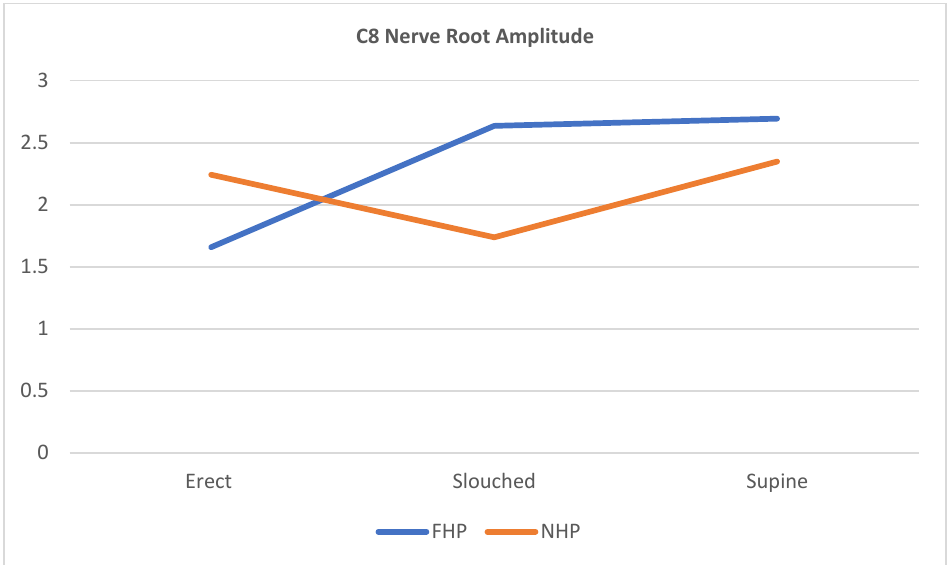
Figure 9. Scatterplot line of cervical nerve C8 amplitude relationship with the different sitting positions for participants with forward head posture (FHP) and normal head posture (NHP). The graph highlights that the FHP group has shown an increased amplitude during slouched sitting compared to erect sitting. The supine position shows the highest nerve peak from all three positions.